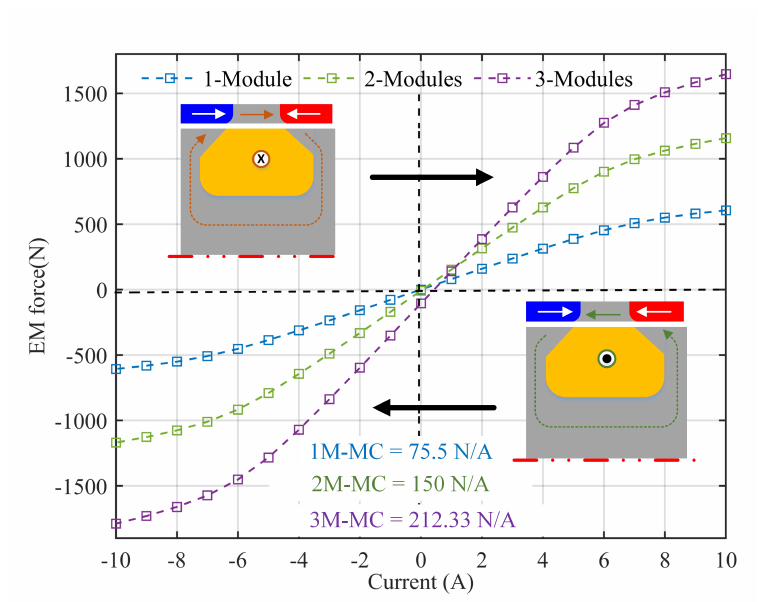
Figure 11. Thrust force of the proposed TMM-LOA under static conditions.